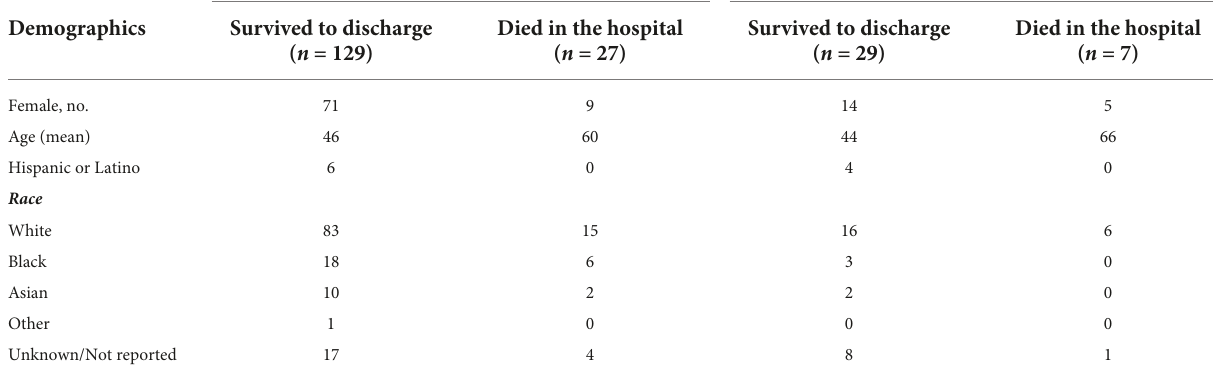
TABLE 1 Demographics of training and test datasets.